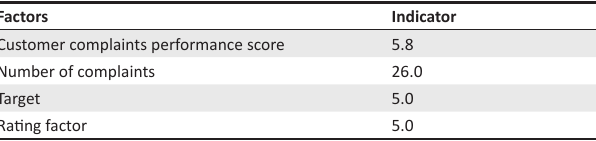
TABLE 2: A performance